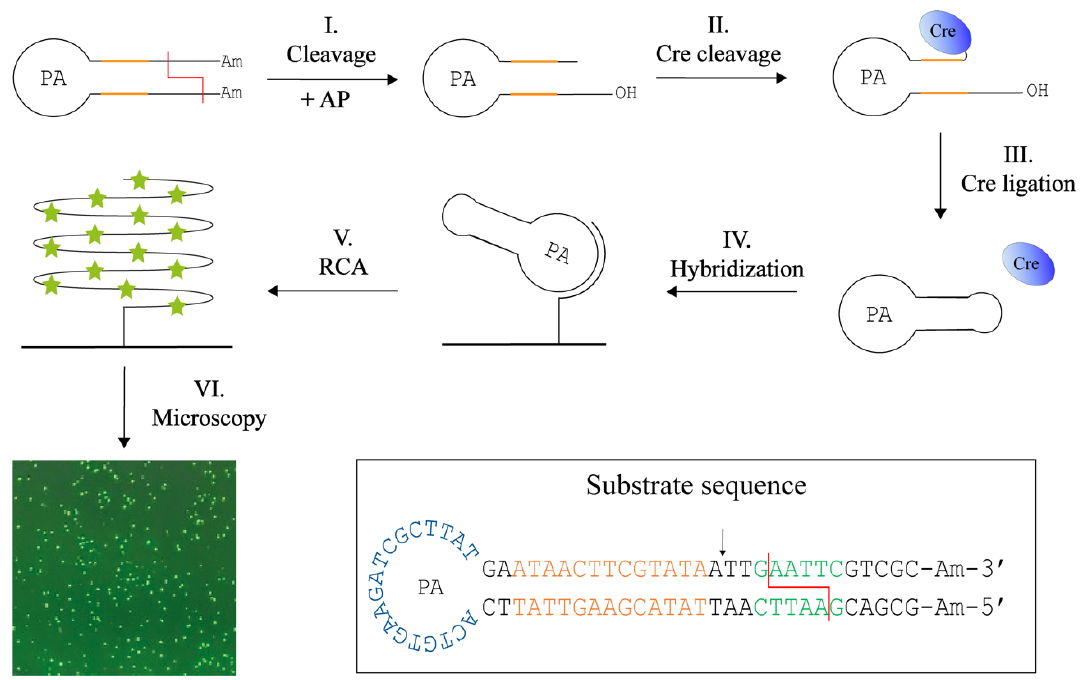
Figure 4. Cre-assisted RE detection. This method uses one DNA hairpin substrate containing Cre (orange) and RE (red) recognition sites in the stem, the primer annealing (PA) sequence in the loop and amine (Am) blocked ends. Following digestion in the presence of alkaline phosphatase (AP) that removes the 5 (cid:48) phosphate end (I), Cre will bind and cleave at the 3 (cid:48) end of the DNA substrate, leaving Cre covalently attached (II) and leave the substrate with a 5 (cid:48) overhang of six bases. Cre is able circulariza the substrate by ligation of the protruding 5 (cid:48) end (III). This circle is hybridized to a primer immobilized on a microscopic glass surface (IV). From the primer, rolling circle amplification (RCA) is also initiated. RCA is performed with ATTO-488 labelled dUTPs which are incorporated into the long tandem repeat product (V). This enables visualization in a fluorescent microscope (VI). The sequence and folding of the DNA substrate can be seen in the box with the Cre recognition site (orange) and Cre cleavage site (arrow), RE site (green), here examples with EcoRI, and RE cleavage (red line), the PA (blue) in the loop, and the amines (Am) blocking the